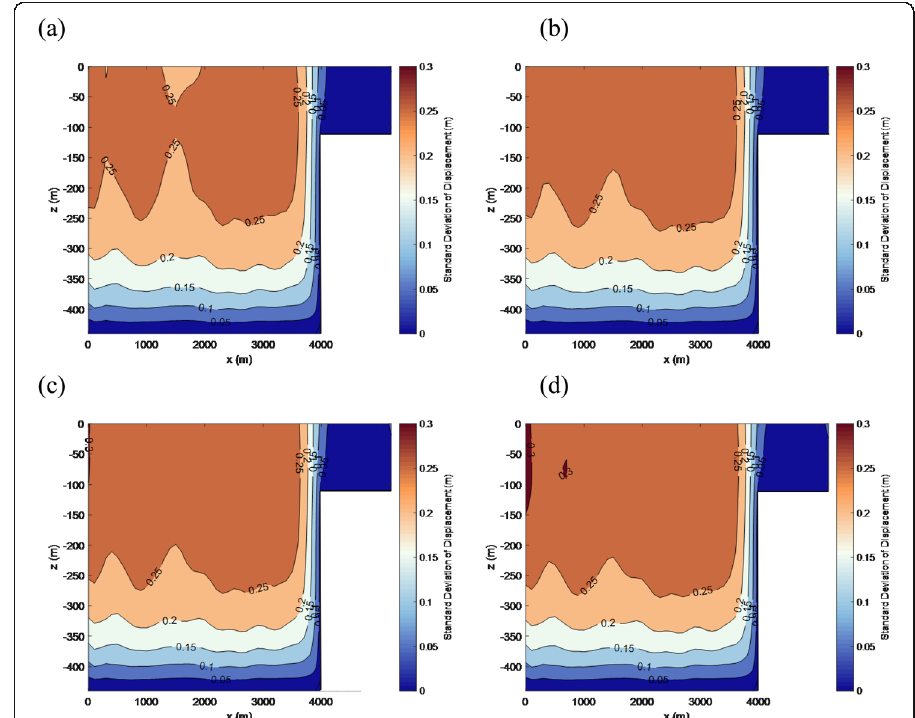
Fig. 10 Uncertainty of displacement over the years considering the spatial variability of E a ( l x = 200 m, l z = 40 m, COV = 0.3). a Year 1. b Year 4. c Year 7. d Year